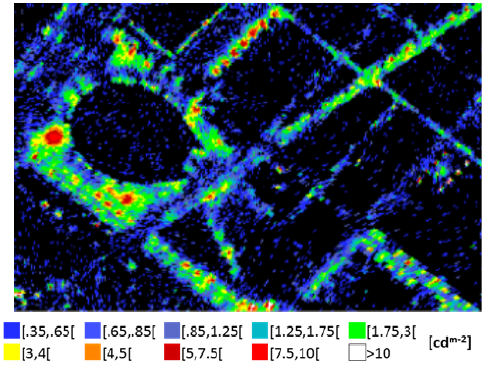
Figure 1. Low resolution map derived from Hyperspectral sensor. Segmentation in 10 classes